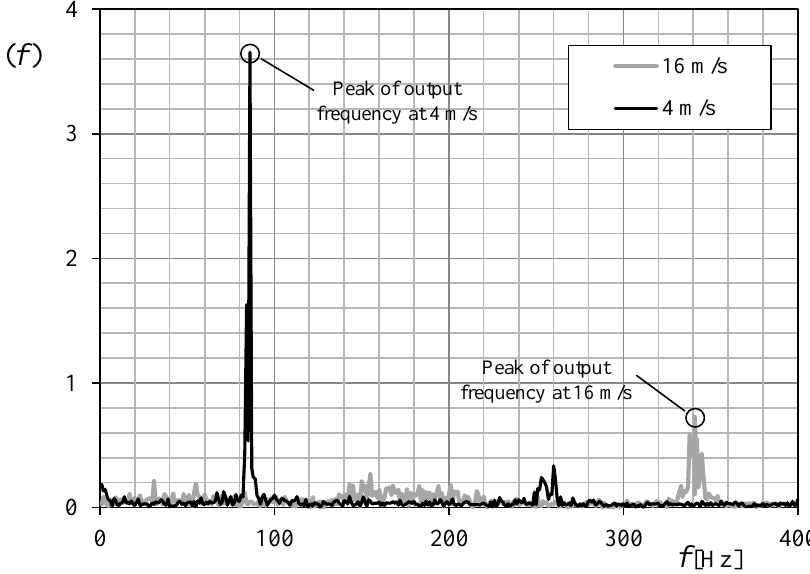
Figure 15. Number sample points (open circles) measured with ABDAS into three 2-period brackets of the three tested cup anemometers’ output signal.